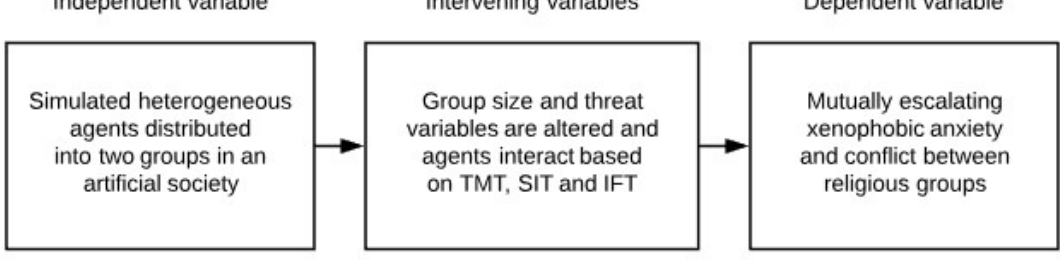
Figure 2: Variable dependencies within